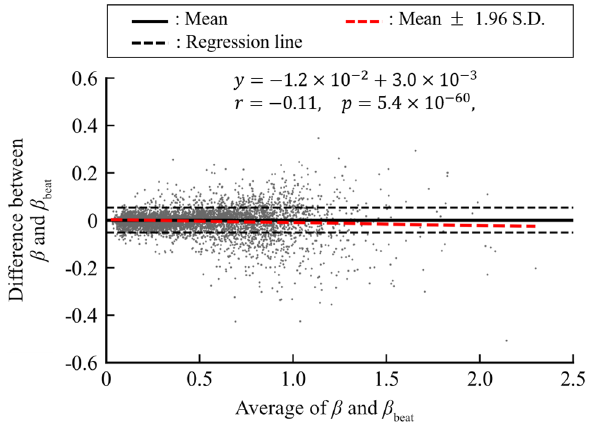
Figure 2. Bland–Altman plot between proposed peripheral arterial stiffness β and conventional peripheral arterial stiffness β beat .